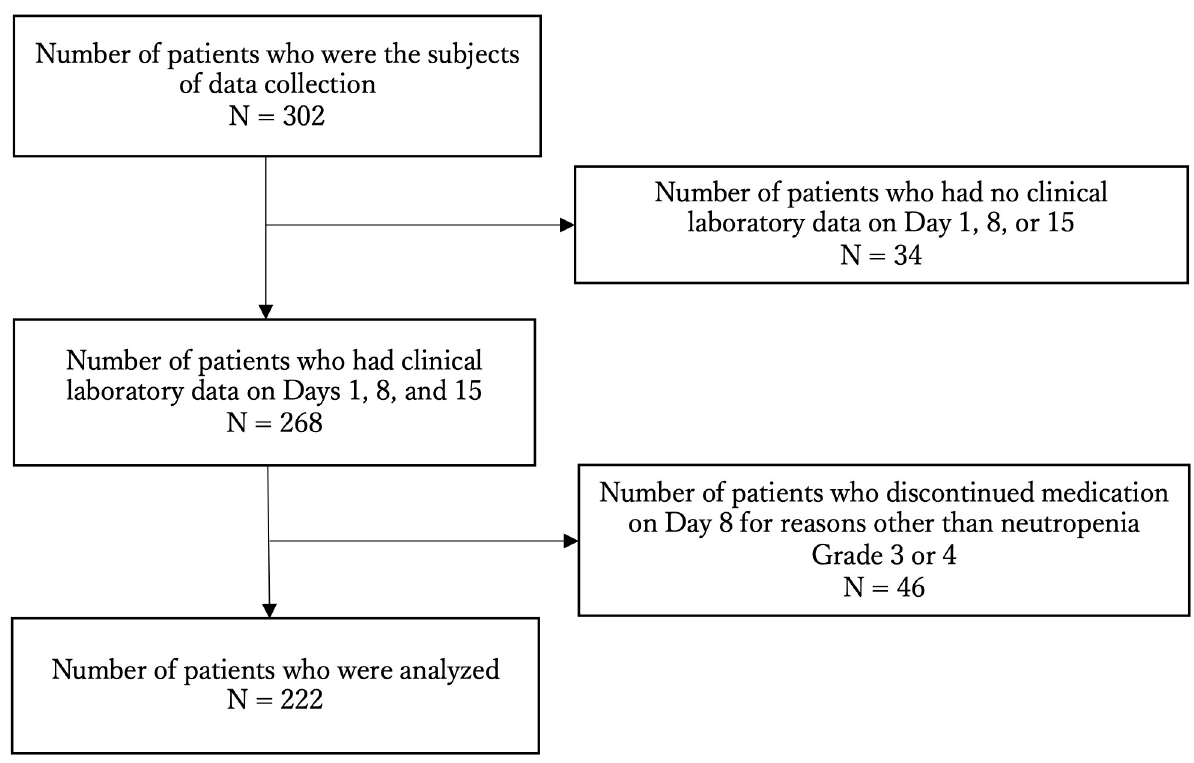
Fig 1. Patients included in this